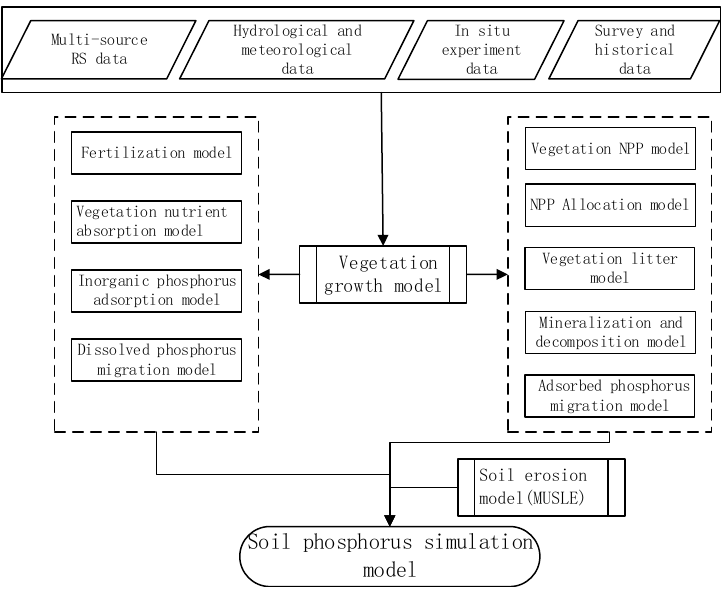
Figure 4. Conceptual framework of the soil P model.